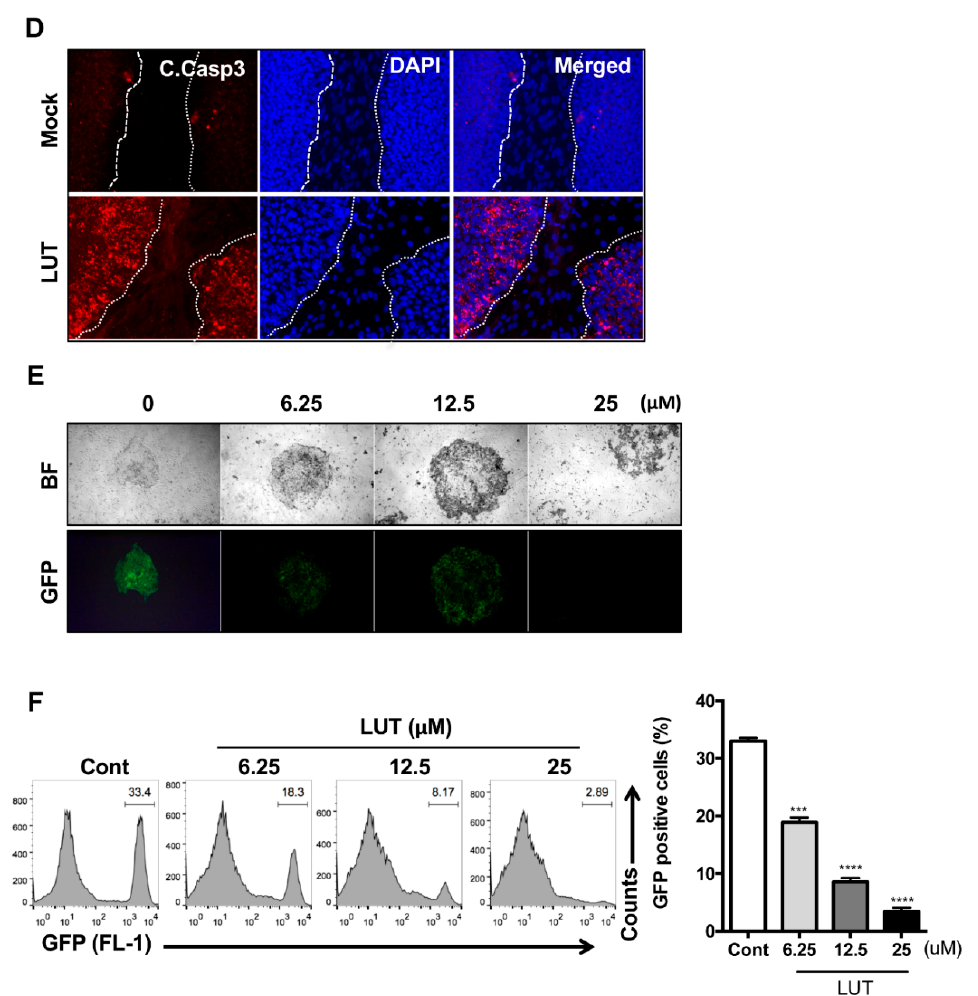
Figure 3. Selectivity of luteolin toward hPSCs. ( A ) Flow cytometry for Annexin V / 7-AAD assay (left) and graphical presentation of live cells (Annexin V and 7-AAD negative population, right) 24 h after treatment of an indicative concentration of luteolin in hiPSCs and SMC ( n = 2). ( B ) Immunoblotting analysis for PARP-1 (F: full and C: cleaved), cleaved caspase 3 (C.Casp3), cleaved caspase 9 (C.Casp9) in hiPSCs and SMC at 24 h after treatment with the indicated concentrations of each flavonoid, and α -tubulin for equal loading control. ( C ) Flow cytometry for Annexin V/7-AAD assay (right) and graphical presentation of live cells (Annexin V and 7-AAD negative population, left) 24 h after treatment with the indicative concentrations of luteolin in hESCs and PVPCs ( n = 2). p < 0.0001 (****). ( D ) Immunofluorescent microscope images of a mixture of hESC and PVPCs at 24 h after LUT treatment (12.5 μ M). White spotted lines divide hESCs and PVPCs (scale bar = 50 μ m). ( E ) Microscope images (top) and fluorescent images (bottom) of a mixture of EGFP expressing hESCs and PVPCs at 24 h after indicated the concentration of luteolin (LUT) (scale bar = 200 μ m). ( F ) Flow cytometry (left) and graphical presentation (right) for the GFP positive population in the mixture of EGFP-hESCs and PVPC at 24 h after the indicative concentration of luteolin (LUT) treatment ( n = 2). p < 0.001 (***), p < 0.0001 (****).